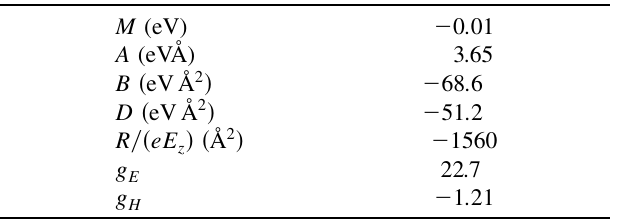
TABLE I. Parameters for a 2D HgTe quantum well with thickness d ¼ 70 (cid:5)A [43]. At such a thickness, the system hap- pens to realize a topological insulator, though this property is inconsequential for the formation of gate-defined wires in the bulk of the quantum